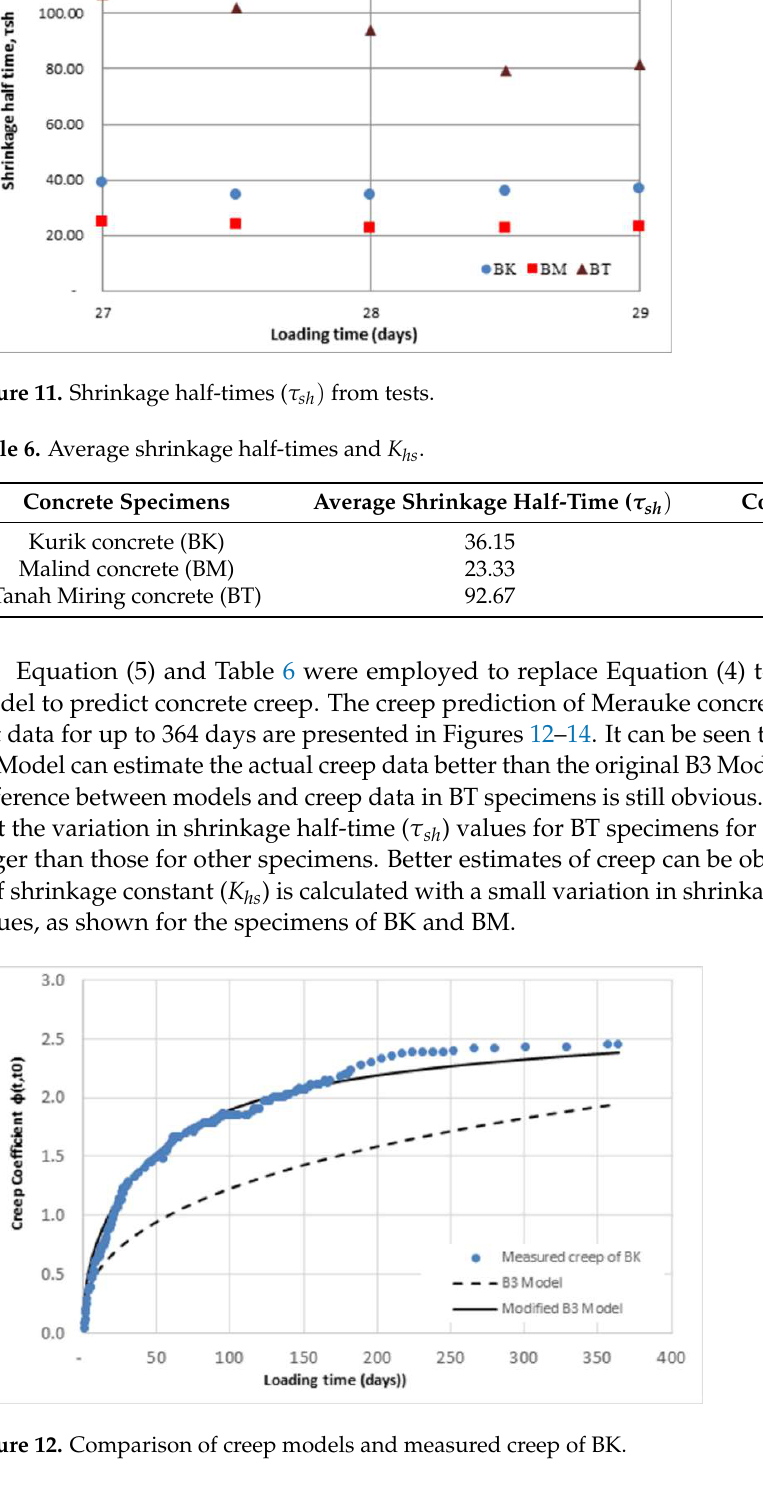
Figure 12. Comparison of creep models and measured creep of BK.